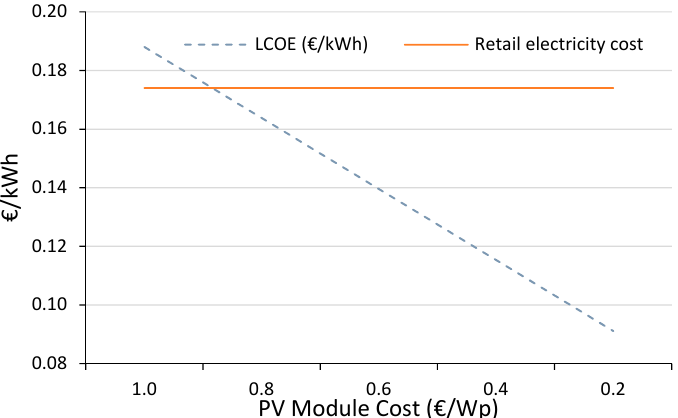
Figure 14. Analysis of the LCOE against the retail electricity cost at a fixed interest rate of 10% (500,000 W inverter, deterministic method).